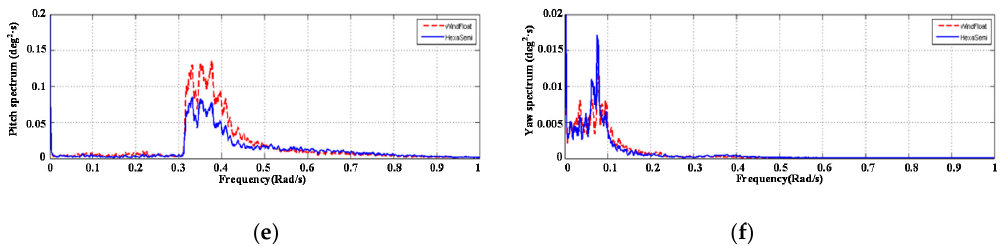
Figure 16. 6-DOFs motion spectrum under the storm condition: ( a ) surge, ( b ) sway, ( c ) heave, ( d ) roll, ( e ) pitch, ( f ) yaw.